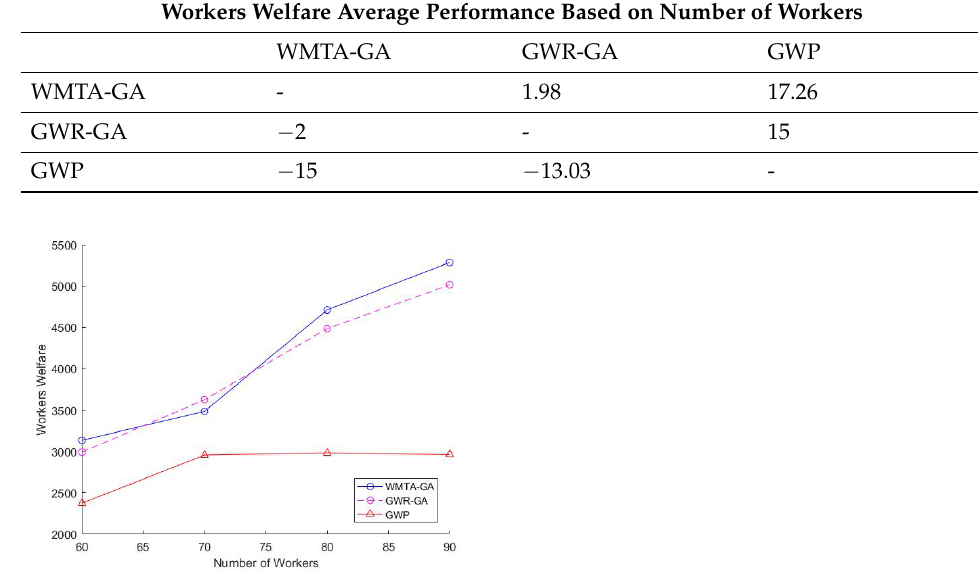
Figure 4. Impact of Varying Number of Workers on Worker